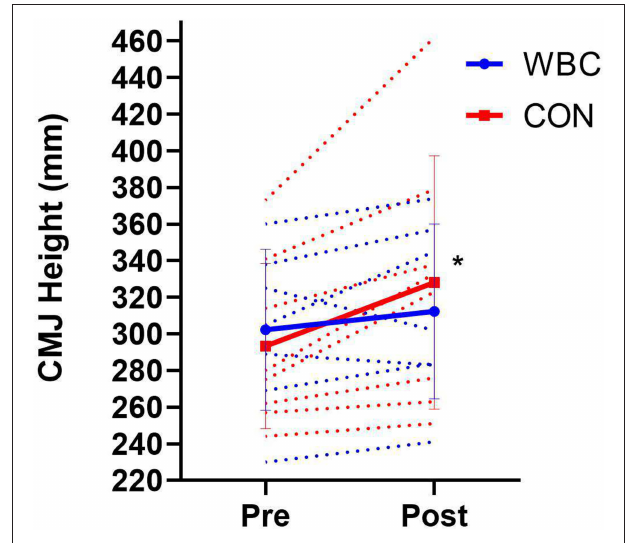
FIGURE 6 | Countermovement jump height for WBC ( n = 7) and CON ( n = 9) before and after 6 week training programme. * p < 0.05 for increase in CON group. Solid lines present means ± standard deviations. Dotted lines present individual participant responses. N =